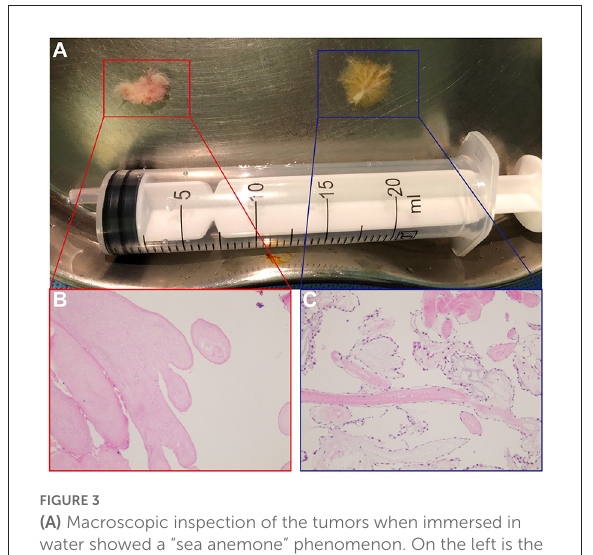
FIGURE3 (A) Macroscopic inspection of the tumors when immersed in water showed a “sea anemone” phenomenon. On the left is the tumor on the aortic valve, and on the right is the tumor in the right atrium. (B,C) Histopathologic examination of the tumors [panel (B) represents the tumor on the aortic valve and panel (C) represents the tumor in the right atrium] with hematoxylin-eosin staining (100 × ) confirmed the diagnosis of cardiac papillary fibroelastomas.